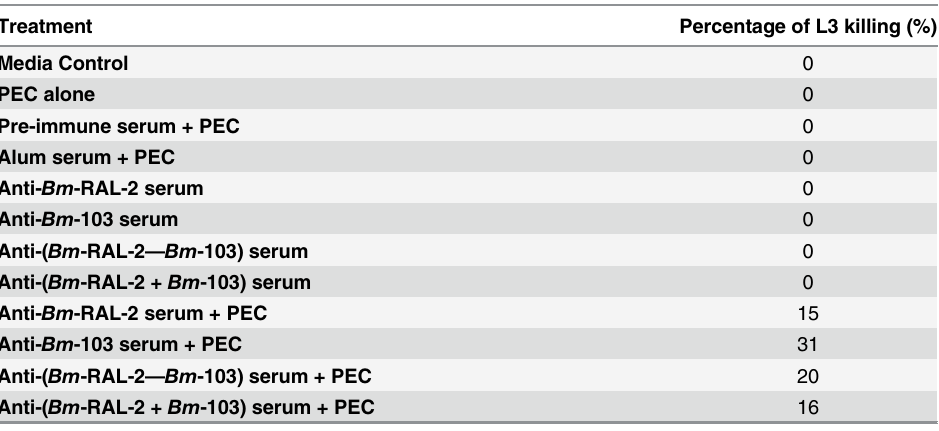
Table 5. Brugia malayi L3 larvae in vitro killing